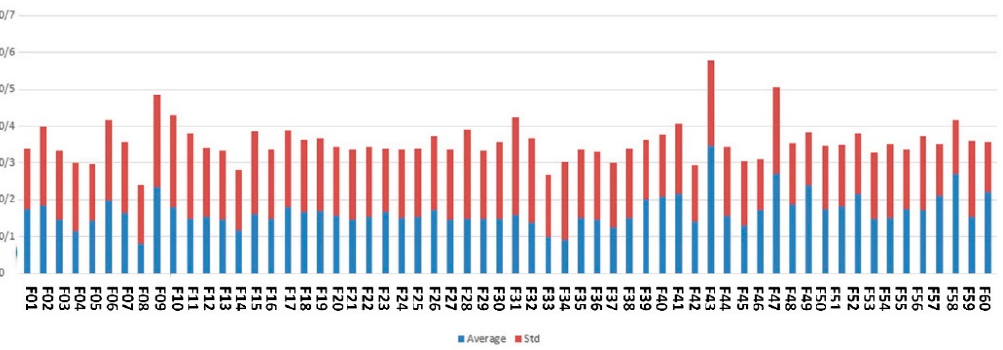
Figure 5. The average and standard deviation of the feature scores according to the results of en- semble of wrapper methods in this study for Apgar score prediction.